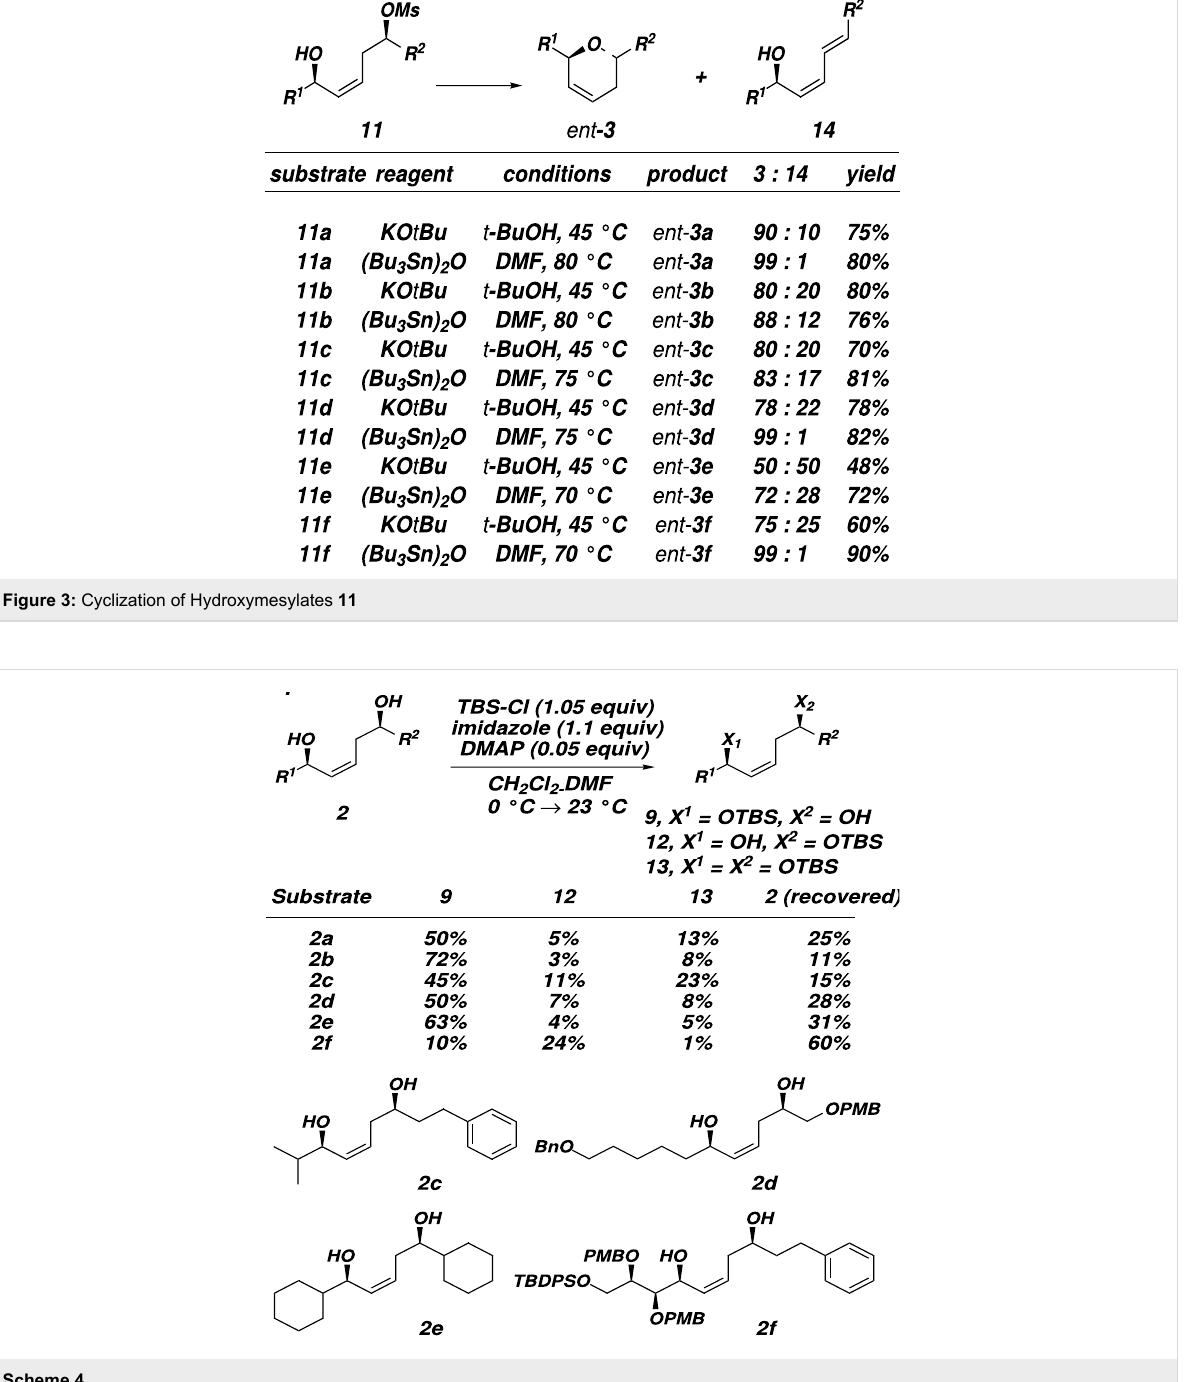
(Figure 3). Treatment of mesylate 11e containing cyclohexyl groups flanking both the allylic alcohol and the mesylate gave a 1:1 mixture of ent - 3e and 14e . α-Oxygenated substrates 11d and 11f cyclized with 3.5:1 and 3:1 selectivity under these